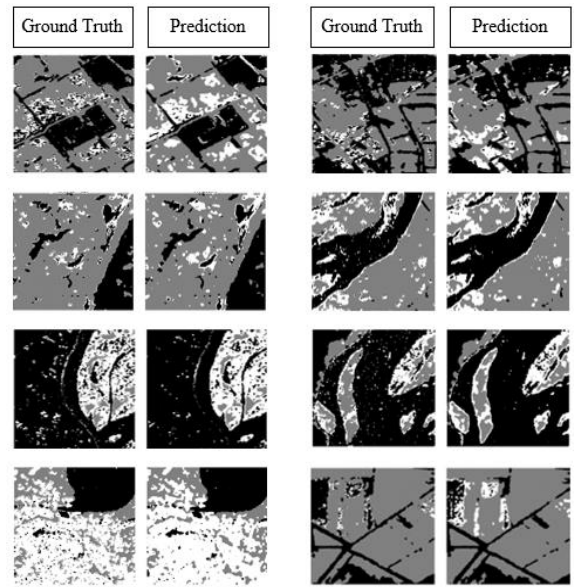
Figure 6 . Views of mask (ground truth) and the model prediction results from Sardoba site obtained from the test split of training dataset.